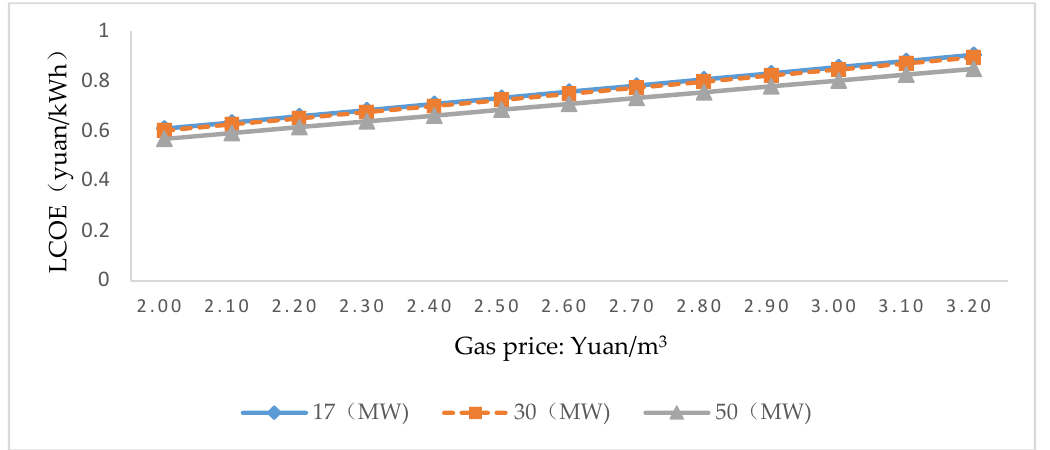
Figure 24. LCOE under different gas prices in CCHP scenario.